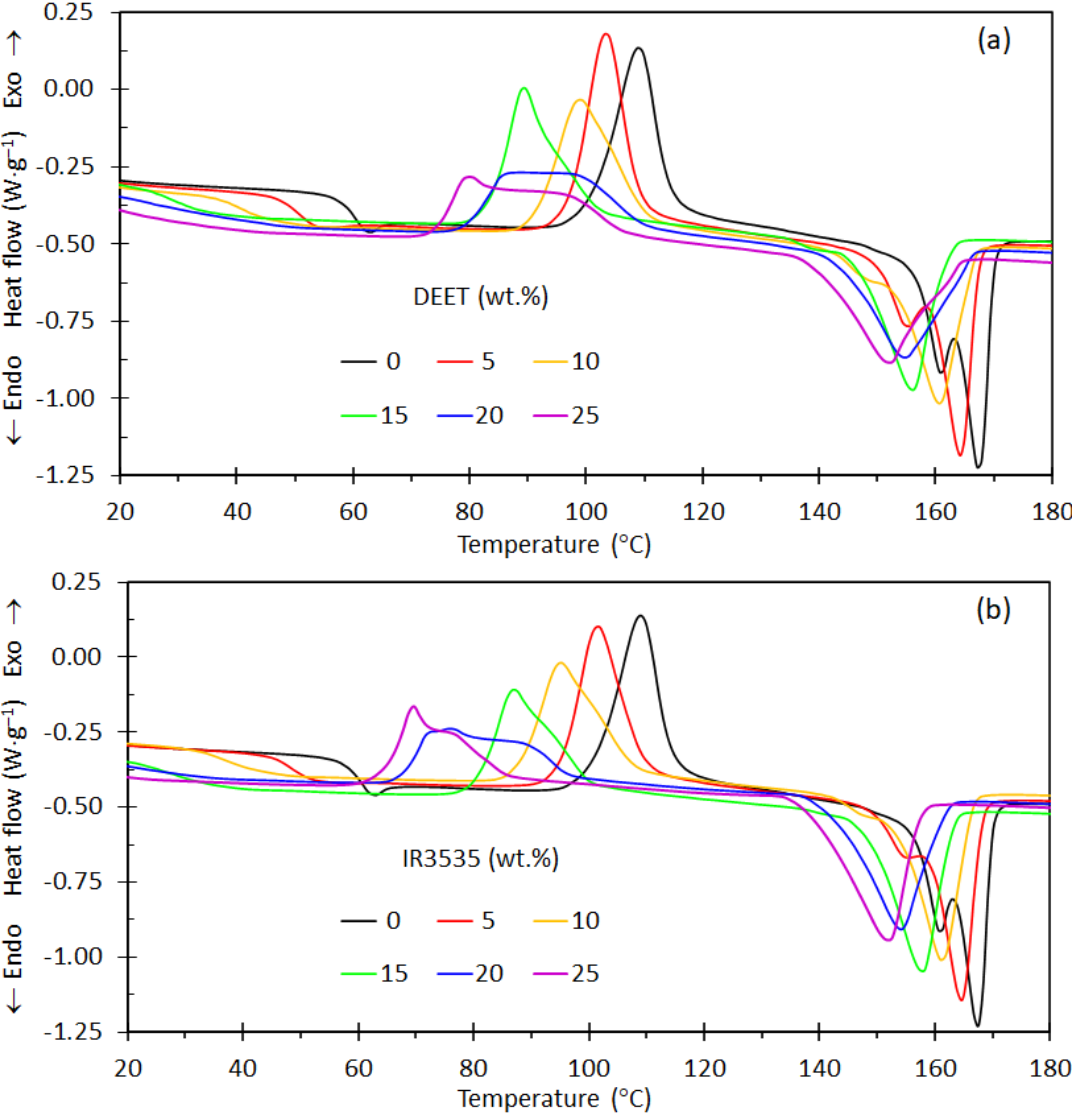
Figure 2. Differential scanning calorimetry traces obtained on the second heating scan for ( a ) neat PLA, PLA/DEET blends and ( b ) neat PLA, PLA/IR3535 blends.